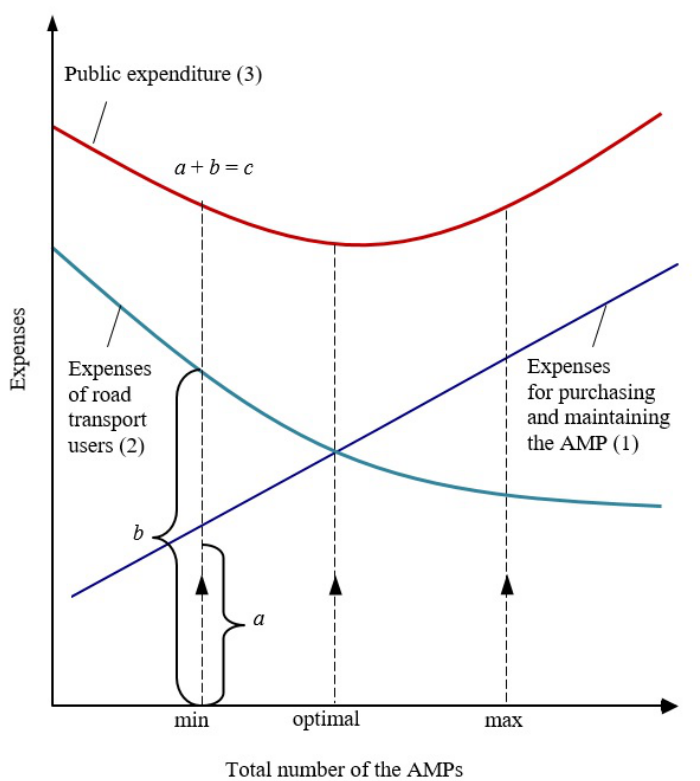
Figure 2. The model of the dependence between the number of AMPs in a country and expenses.